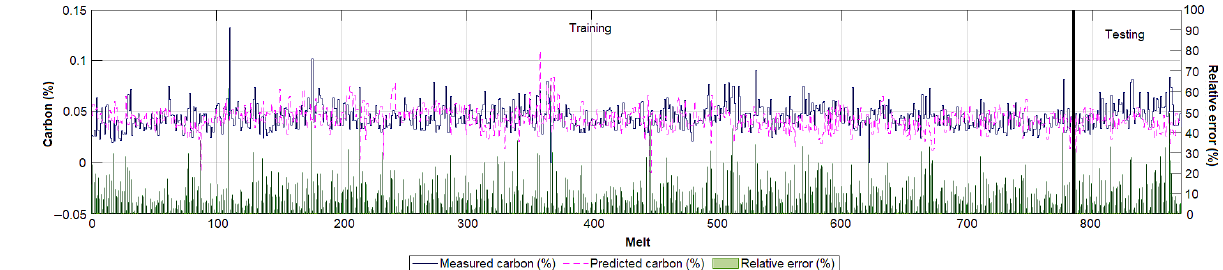
Figure 14. Prediction of endpoint carbon concentration in melt by NN model.